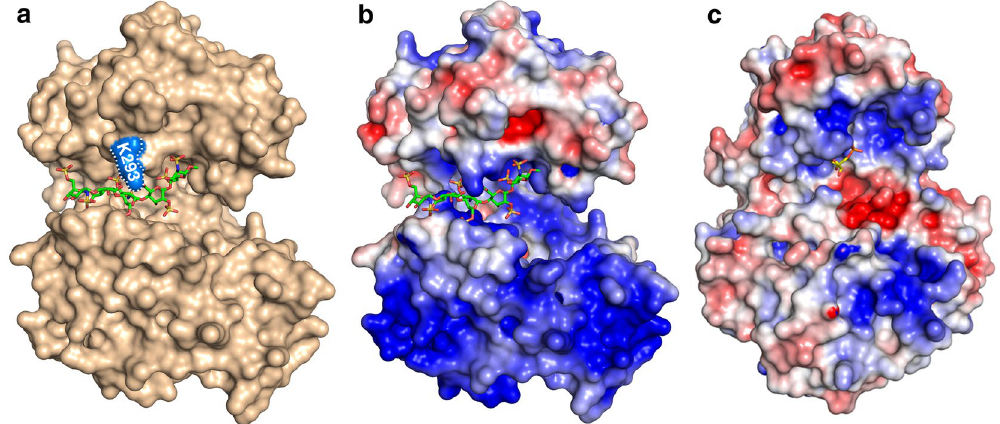
Figure 3. The Mh PST acceptor substrate binding groove at the interface of the N-terminal and the C-terminal domain. ( a ) Surface representation of Mh PST (monomer A in wheat) with bound acceptor ligand analogue fondaparinux shown in green sticks. The surface of residue K293 is coloured in blue and is labelled. ( b ) Electrostatic surface potential of fondaparinux bound Mh PST structure. ( c ) Electrostatic surface potential of CMP bound structure of mono-sialyltransferase PmST1 (PDB: 3s44). ( b , c ) Surface potentials were calculated with the Adaptive Poisson Boltzmann Server 69, 70 with a PARSE force field, with linear interpolation of colours at intermediate potentials (blue, 4 kT/e; red, − 4 kT/e; white, 0 kT/e; probe radius, 1.4